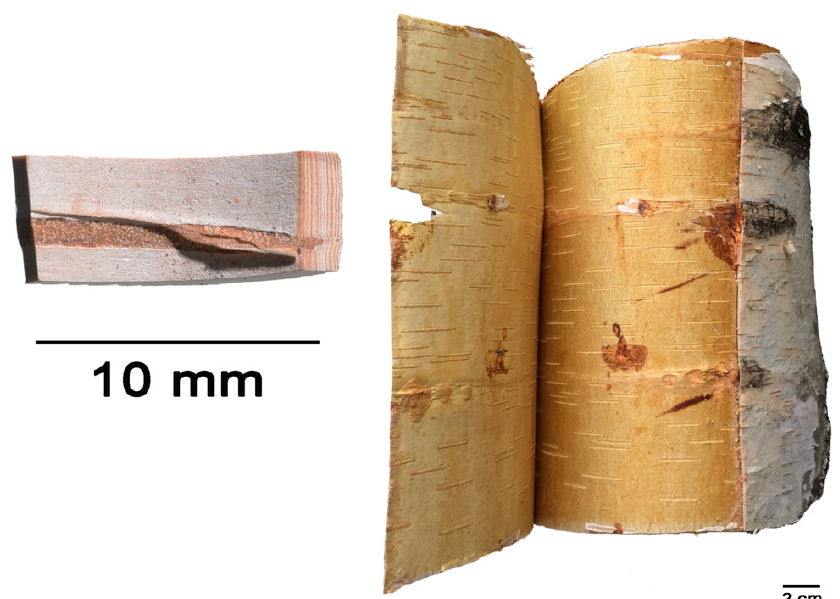
Figure 2. Reference sample ( left ) was extracted from contemporary outer birch bark harvested from a mature tree with strong and pliable phellem ( right ). Sample has white powdery surface due to betulin content and slight delamination is present at the lenticel. Thick- and thin-walled cell bands are recognizable macroscopically as red and white bands, respectively, along the radial section.